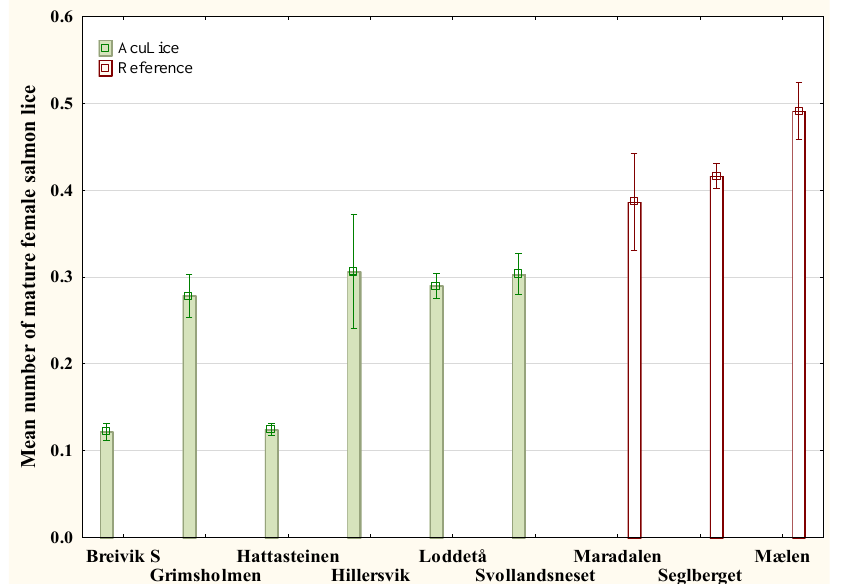
Figure 6. Mean number of mature female salmon lice measured per Atlantic salmon in the period from mid-summer 2019 to late-spring 2020 at each facility. Groups of Atlantic salmon exposed to AcuLice treatment (AcuLice) compared to the reference group (reference). Green-marked columns are facilities with AcuLice treatment and red columns are the reference facilities. Data from each facility is presented as mean ± SEM (N = 60–120).